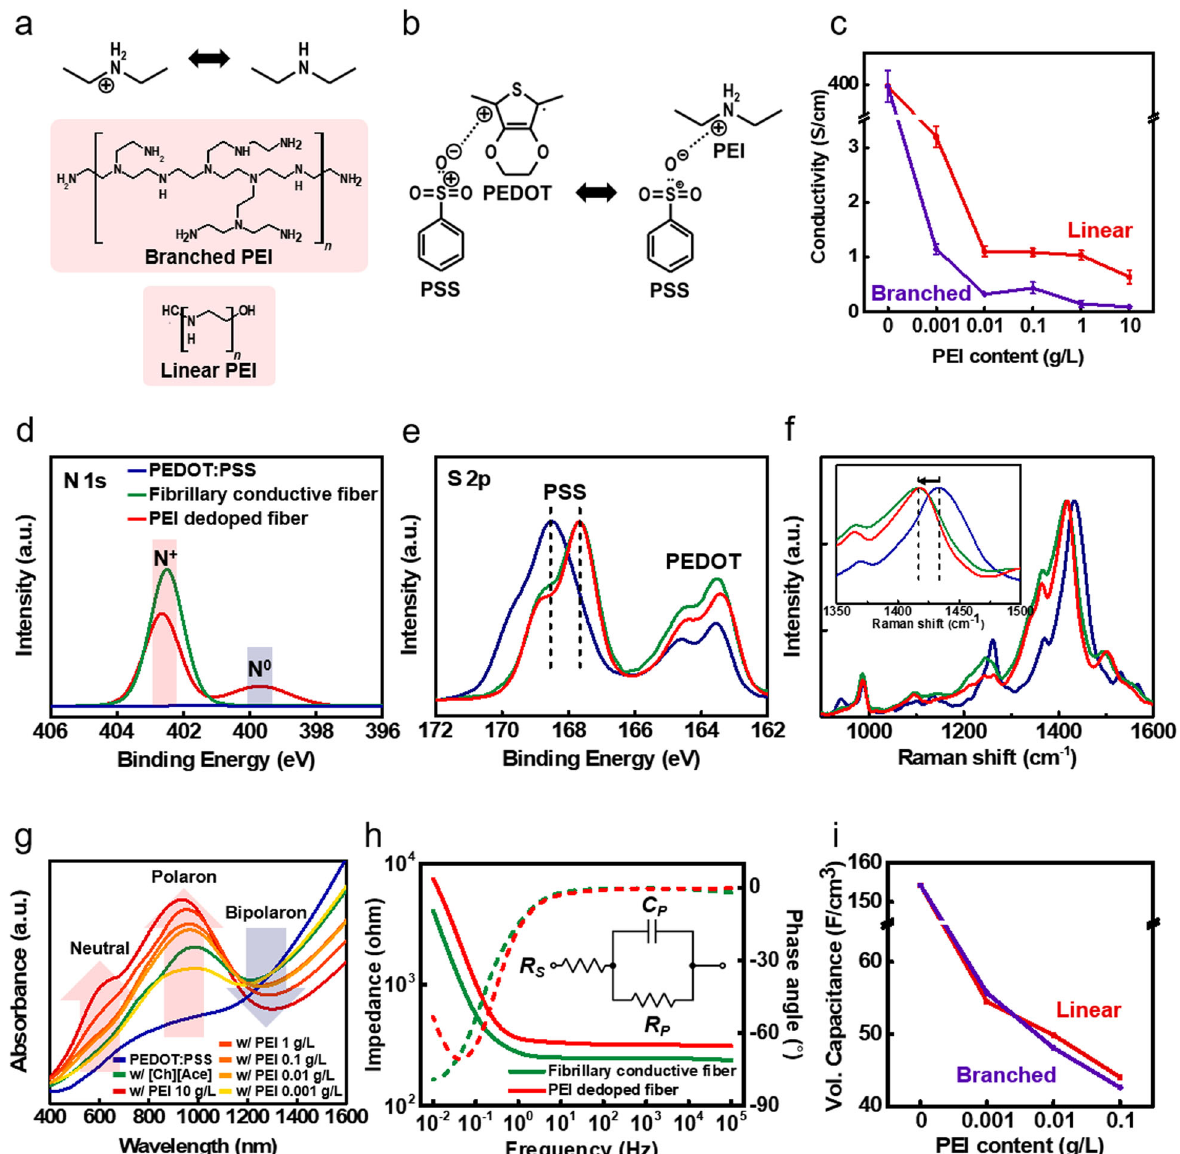
Fig. 3 Electrical, chemical, and electrochemical properties of the PEDOT:PSS conductive gel fi ber. a , b Schematic diagram showing the state of interaction of nitrogen and sulfur, respectively. c Conductivity of the PEDOT:PSS conductive gel fi ber with respect to concentration of linear and branched PEI solution where fi bers are swelled for dedoping process. The error bar is about ±10% d N 1 s XPS spectra, e S 2p XPS spectra, f Raman spectra for PEDOT:PSS surface, PEDOT:PSS conductive gel fi ber by ionic liquid (PEDOT:PSS/choline acetate) and dedoped fi ber by PEI using a 785 nm excitation laser source. g UV-vis-NIR spectra for pristine PEDOT:PSS (blue) and [Ch][Ace] (green), PEI addition, respectively. The higher the PEI concentration (Red), the higher the neutral (~600 nm) and polaron (~900 nm) peaks tend to increase. h Impedance (solid) and phase angle (dash) of fi brillary conductive fi ber and dedoped fi ber as a function of frequency. i Volumetric capacitance of conductive fi bers with respect to concentration of PEI